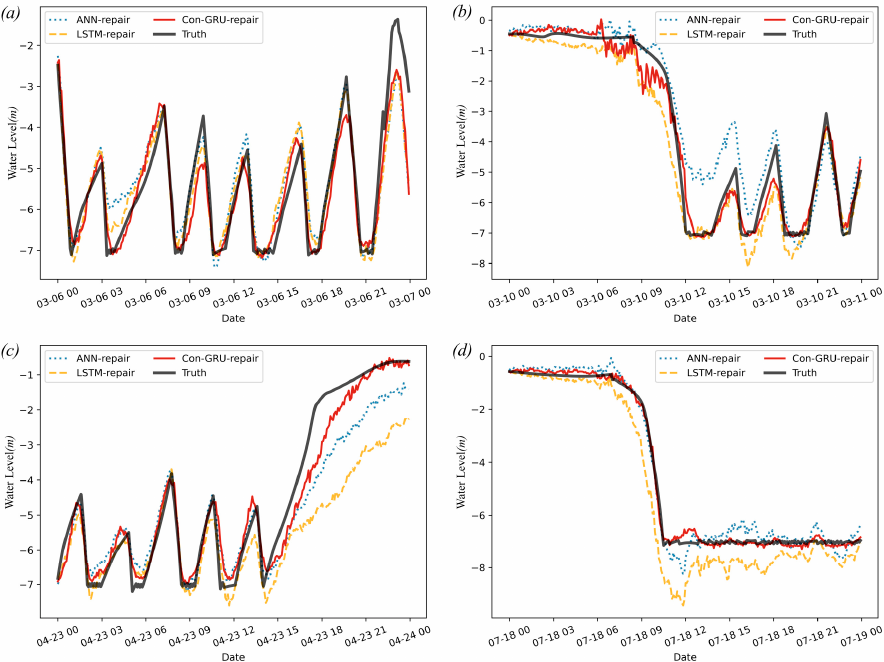
Figure 8. Comparison of three models in iterative repair on validation dataset: ( a ) results of data repair on March 6, 2020; ( b ) results of data repair on March 10, 2020; ( c ) results of data repair on